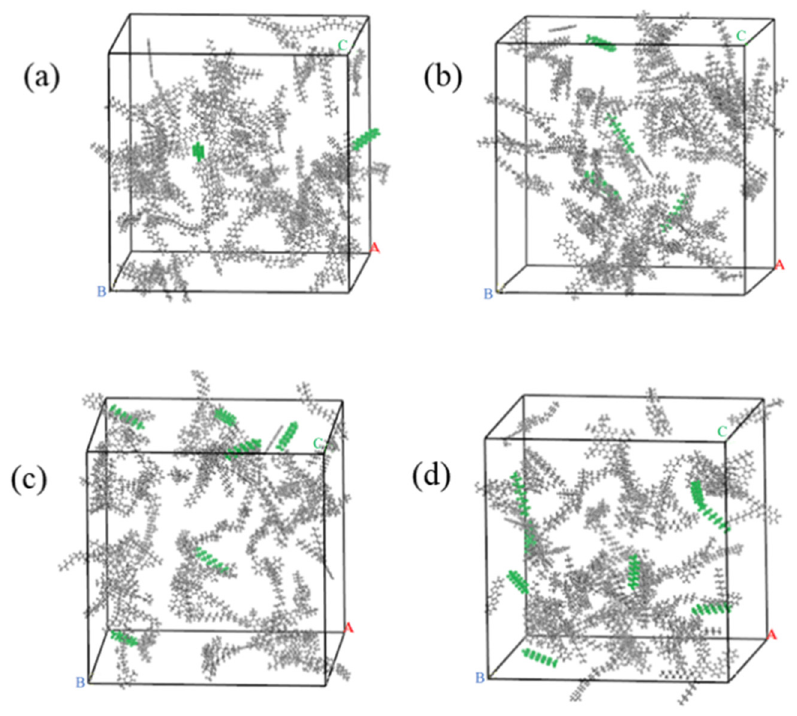
Figure 4. ( a ) WWMA-1 model; ( b ) WWMA-2 model; ( c ) WWMA-3 model; ( d ) WWMA-4 model.